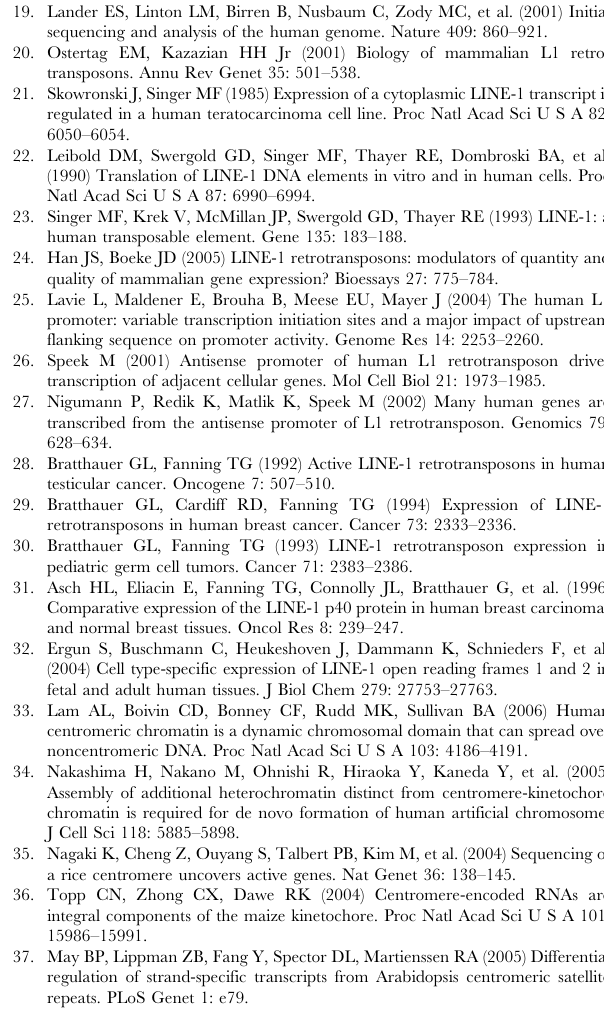
Table S2 Transcription status of FL-L1s within a 6-Mb genomic region of the 10q25 neocentromere.